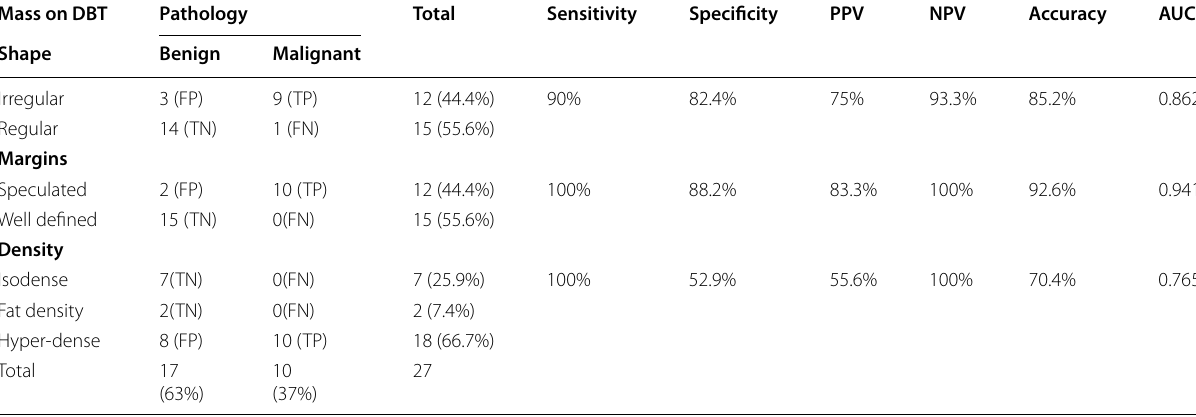
Table 3 Diagnostic performance of DBT in c haracterization of breast masses according to shape, margins and density Mass on DBT Shape